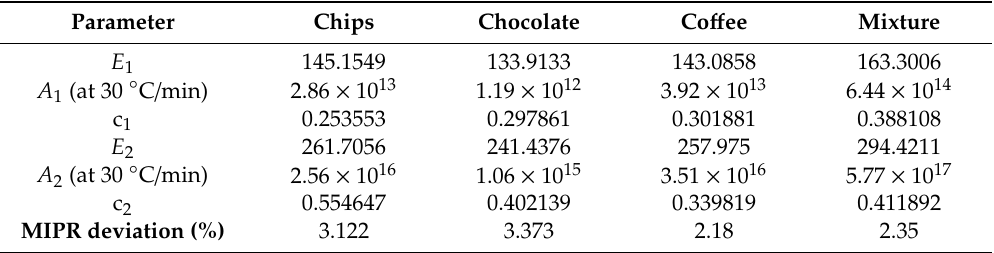
Table 4. The pyrolysis characteristic parameters for MFPW at di ff erent heating